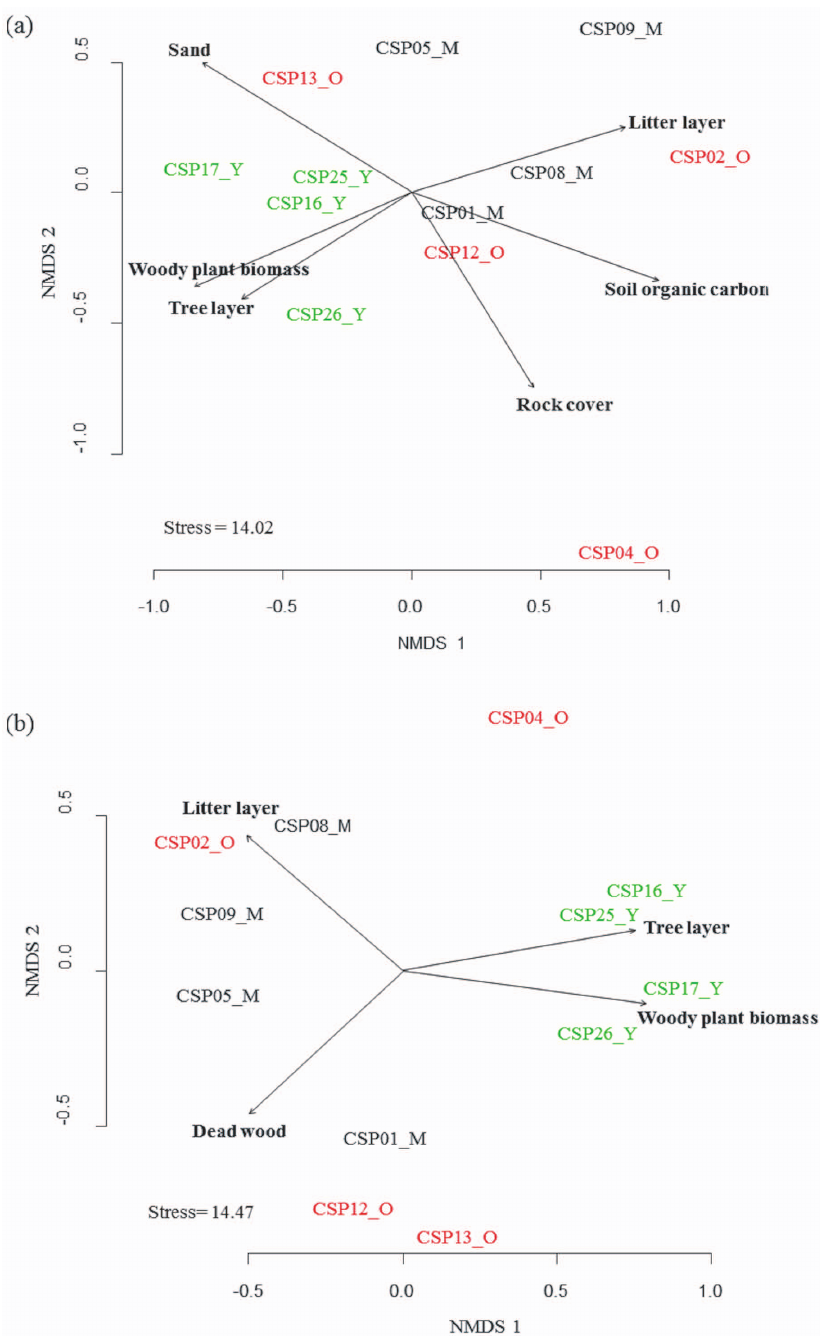
Figure 3. Non-metric multidimensional scaling (NMDS) ordination of the study plots across three forest age classes (Y: Young, M: Medium, O: Old) based on fungal communities of (a) kingdom fungi and (b) ectomycorrhizal fungi. In each diagram, soil and plant characteristics that showed a significant goodness of fit based on post-hoc correlations ( P # 0.05) are represented as vectors. Stress values represent percentages.